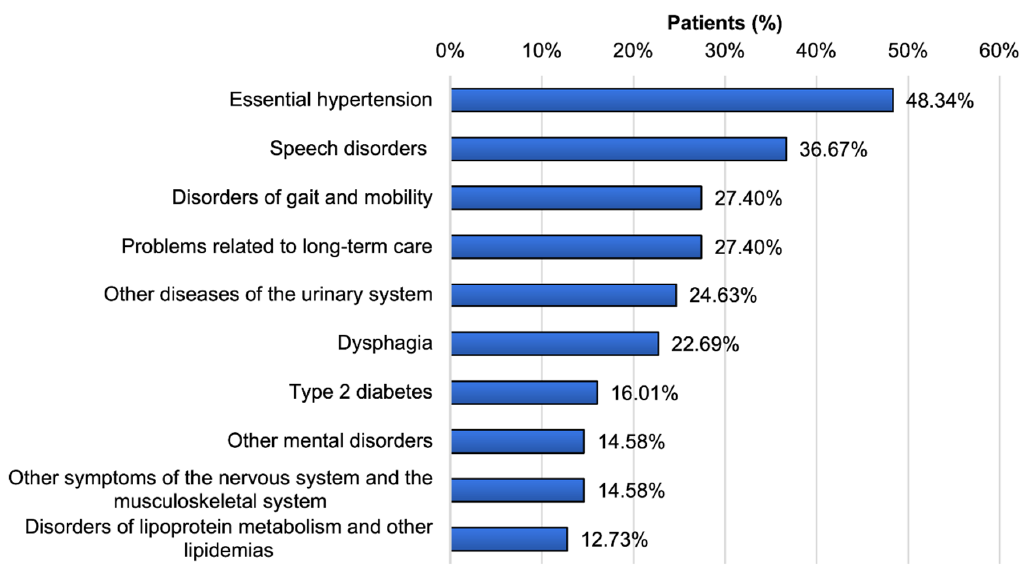
Figure 5. Prevalence of the 10 most frequent comorbidities among patients in the diagnostic group G23.- in 2017.